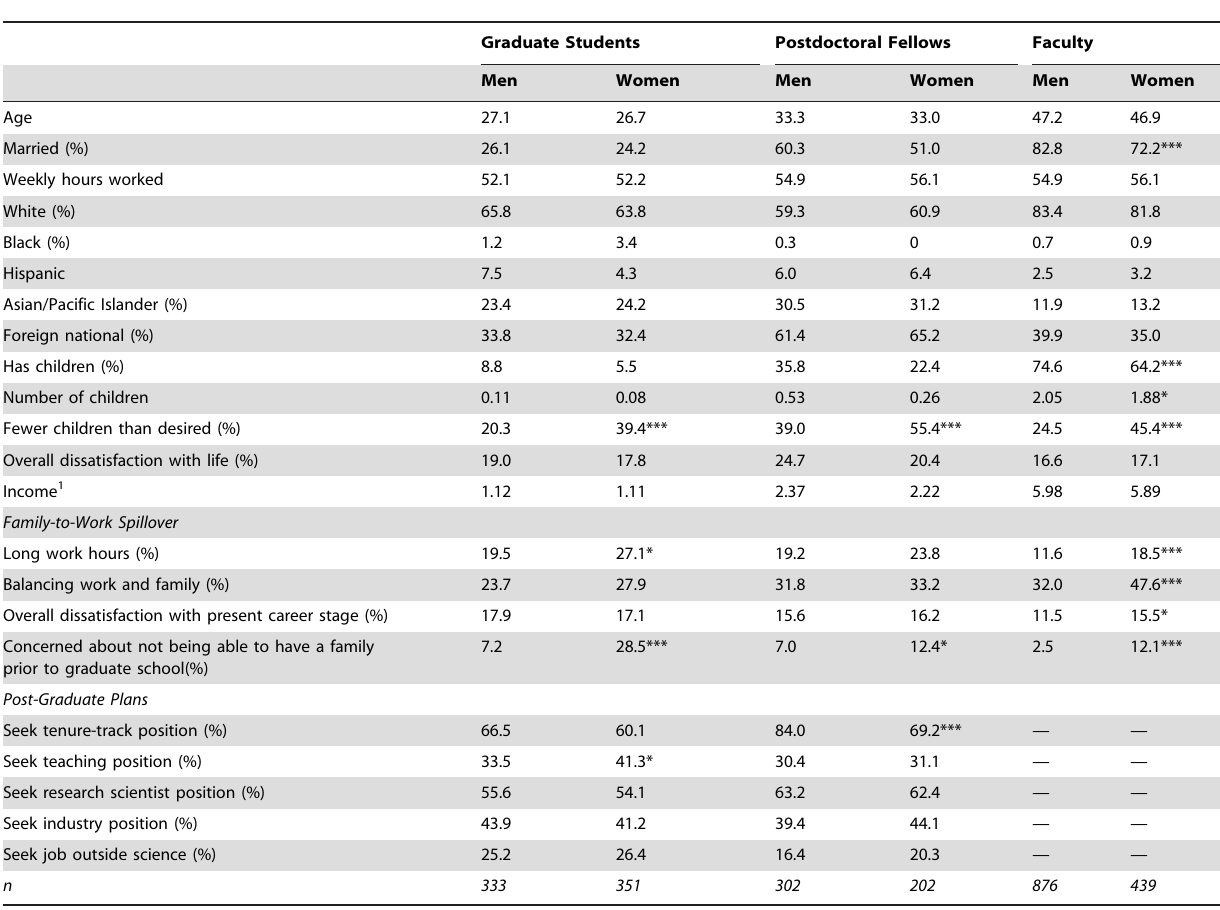
Table 1. Descriptive Statistics for Key Independent Variables by Sex and Career Rank in PWAS